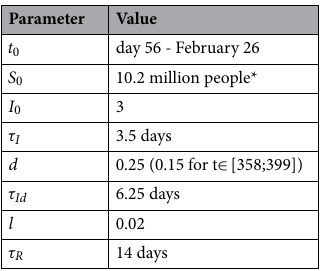
Table 1. Parameters that could not be independently estimated by model fitting the data sets corresponding to infected, dead and hospitalized. *Total Portuguese population, which was assumed